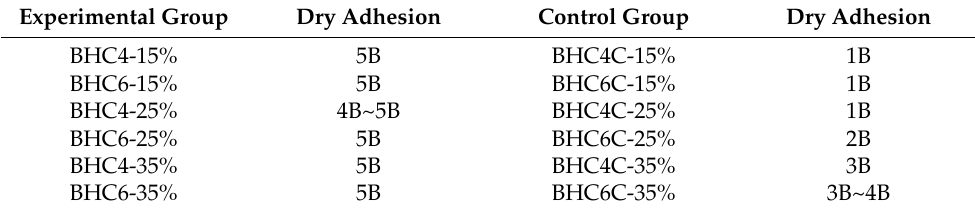
Table 5. Dry adhesion of MF coatings based on ASTM D3359. Experimental